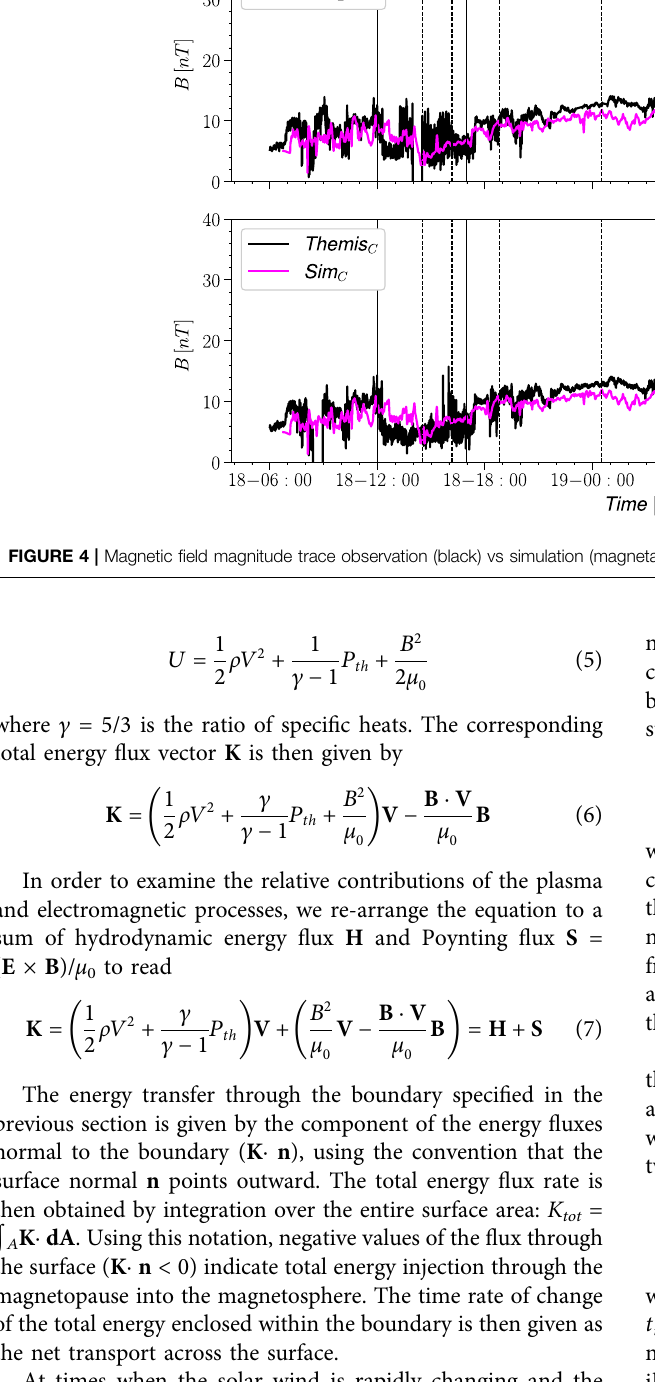
Frontiers in Astronomy and Space Sciences |